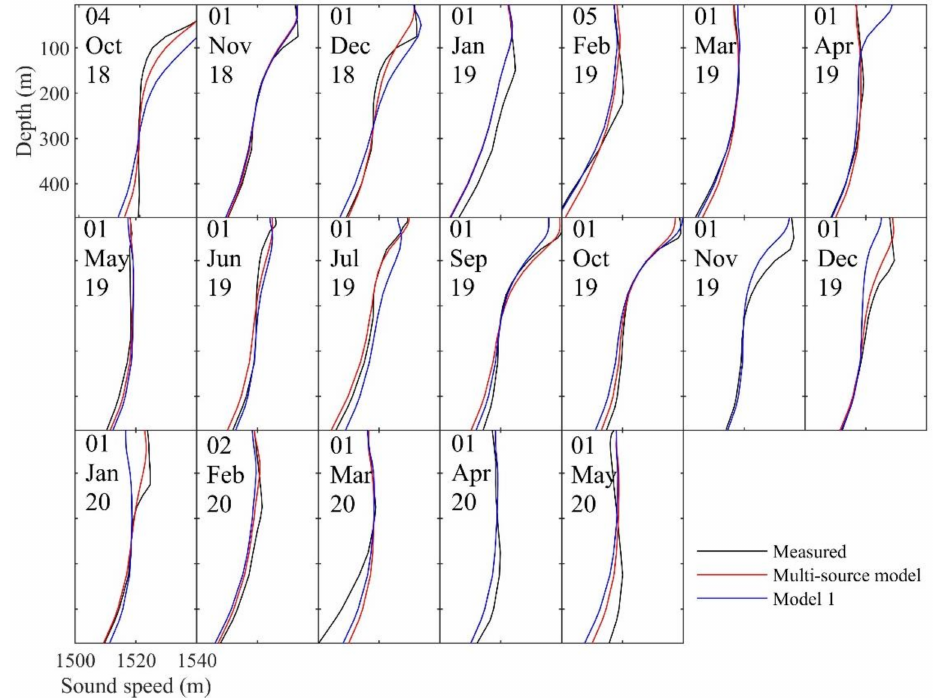
Figure 6. Comparison between the measured and the estimated